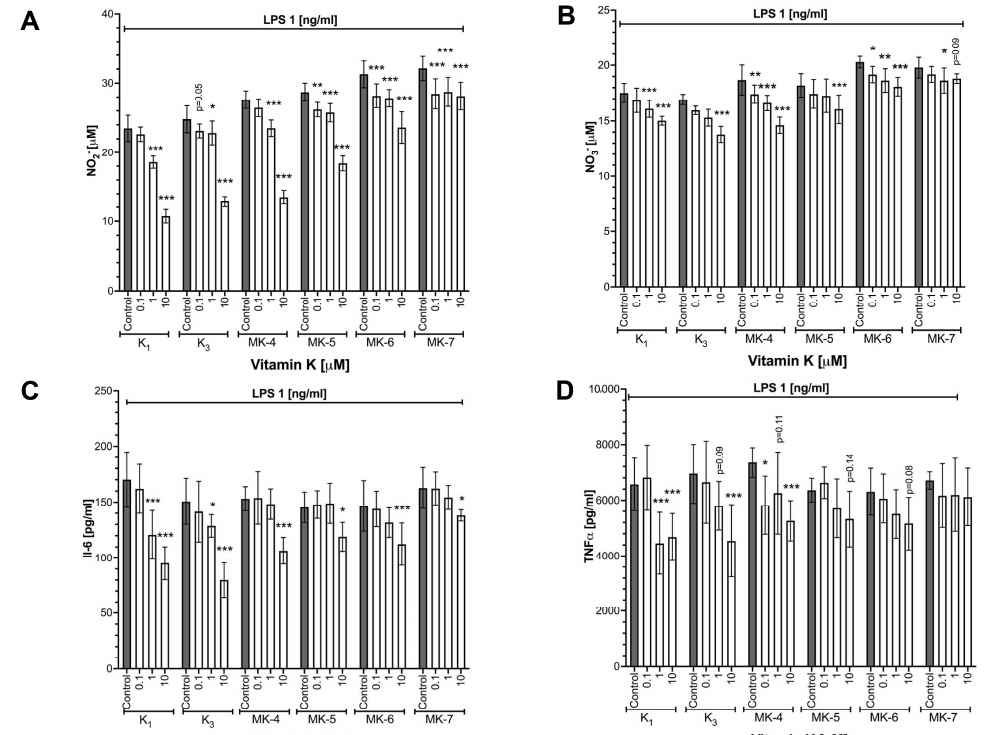
Figure 1 Figure 1. The inhibition of NO (NO 2 − , NO 3 − ) and cytokine (IL-6, TNF α ) production by various forms of vitamins K in RAW 264.7 cells stimulated with LPS. Nitrite ( A ) and nitrate ( B ) production was measured via the ENO-20-NOx Analyzer. The cytokine concentration, IL-6 ( C ) and TNF α ( D ), was measured using ELISA after 48 h incubation with various forms of 10 µ M vitamins K in the presence of 1 ng/mL LPS. Data are shown as means ± SD from three independent experiments and technical replicates without outliers ( n = 6–9). Statistical significance was evaluated by two-way ANOVA followed by Dunnett’s post hoc multiple comparisons using GraphPad Prism 9 software. The symbols *, ** and *** indicate statistical significance at p < 0.05, 0.01 and 0.001,